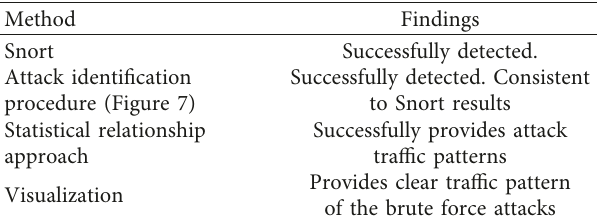
Table 2: Summary of the findings. Method Findings Successfully